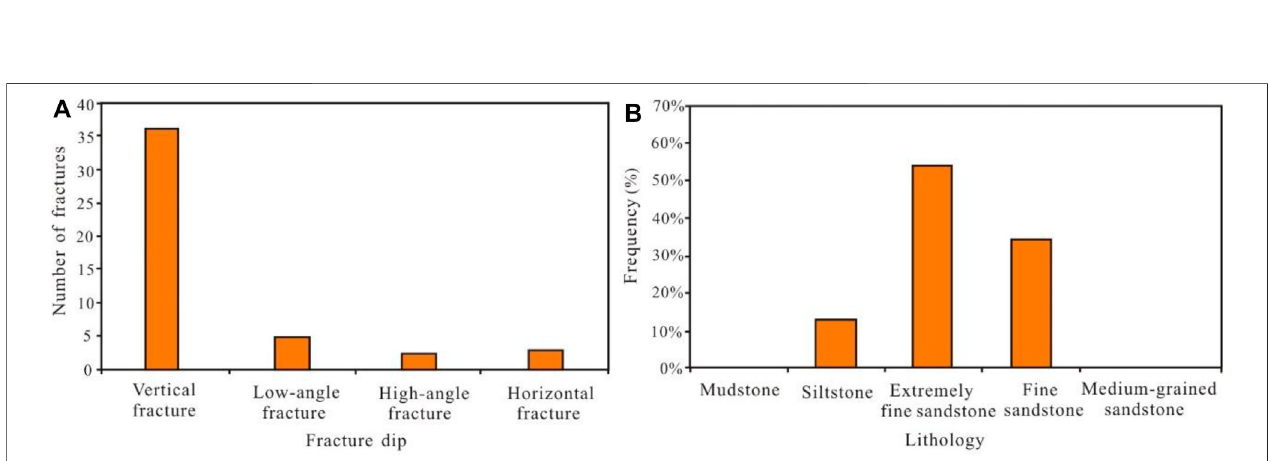
FIGURE 5 | Histogram of fracture parameter distribution. (A) Classi fi cation of fracture types based on fracture dip angle; (B) Classi fi cation of lithological types of sandstone.